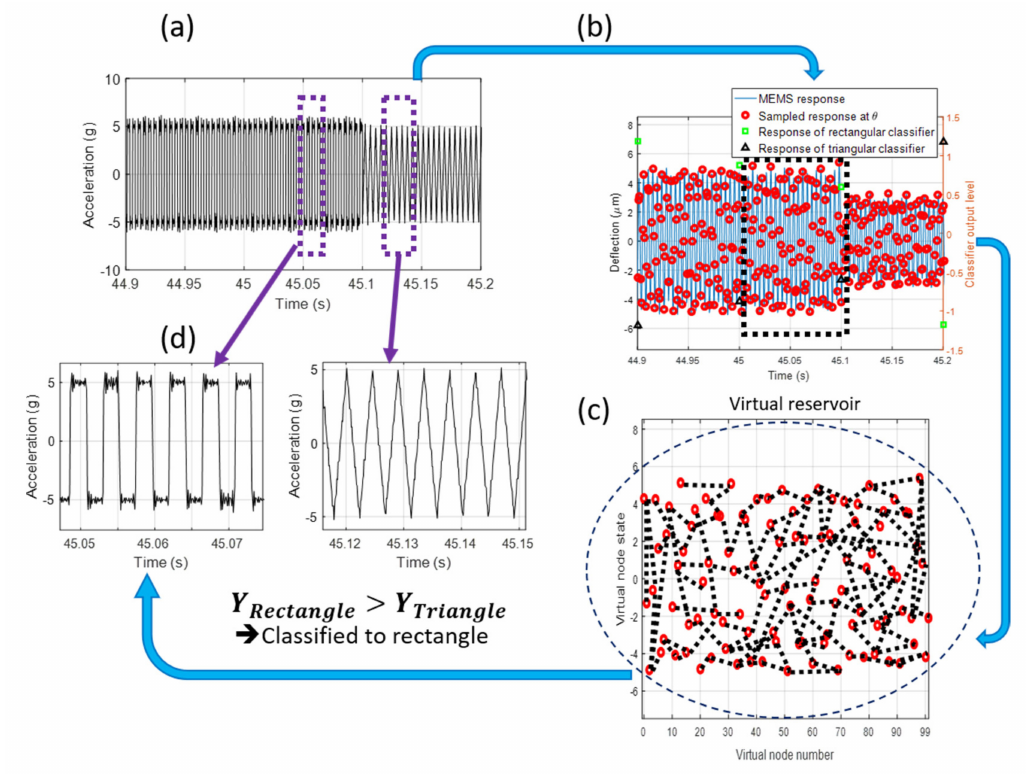
Figure 6. MEMS sense-and-compute scheme: ( a ) a sample of the acceleration signal generated by the shaker. ( b ) The response of the MEMS device and virtual node extraction. ( c ) Visualization of the virtual reservoir within the network. The response of the virtual nodes shown in this figure is used to compute the reservoir output after all the virtual nodes are updated. ( d ) Classification process based on the RC